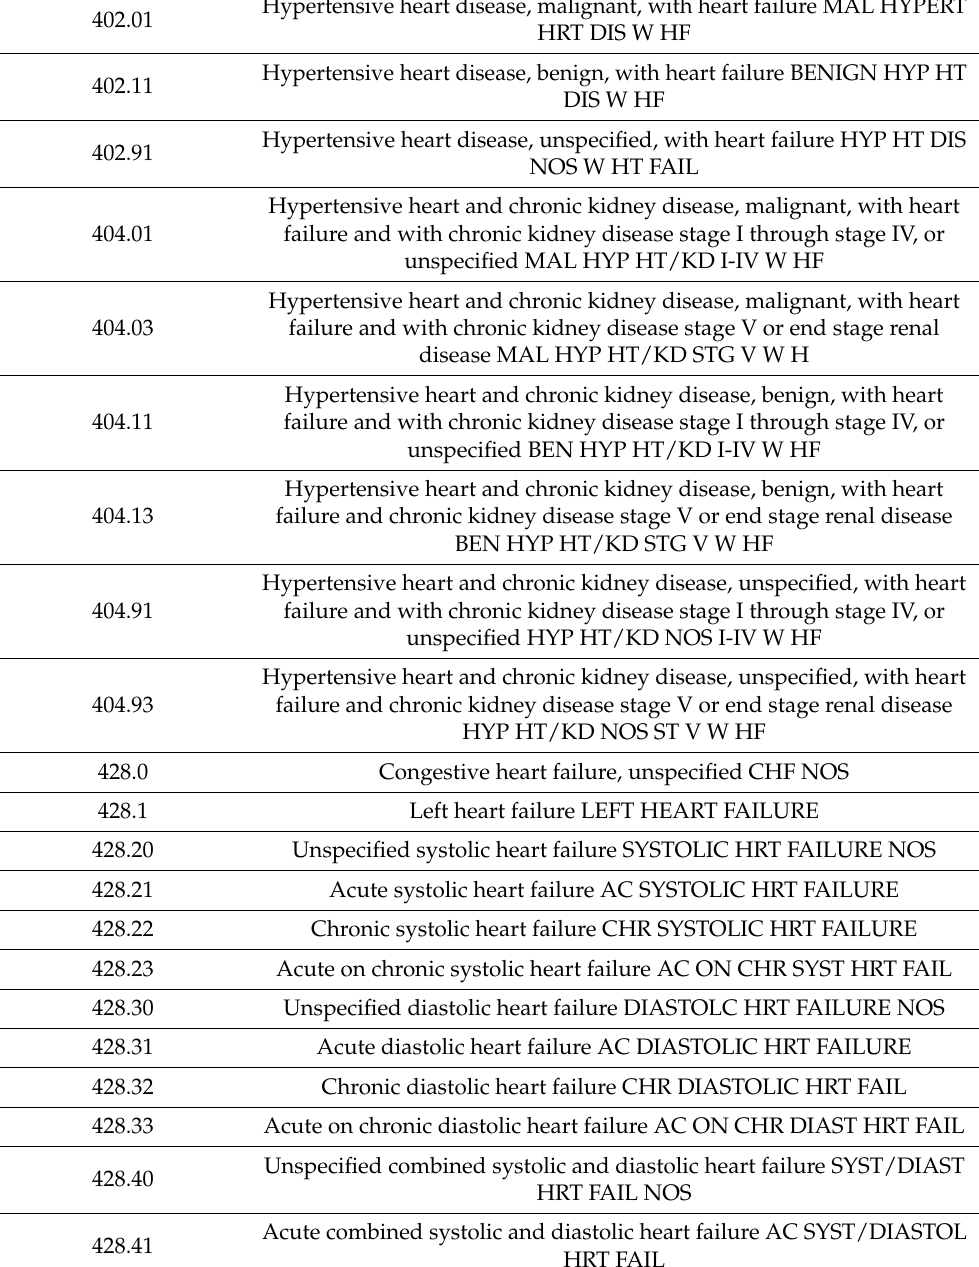
Table A1. ICD-9 Codes for Heart